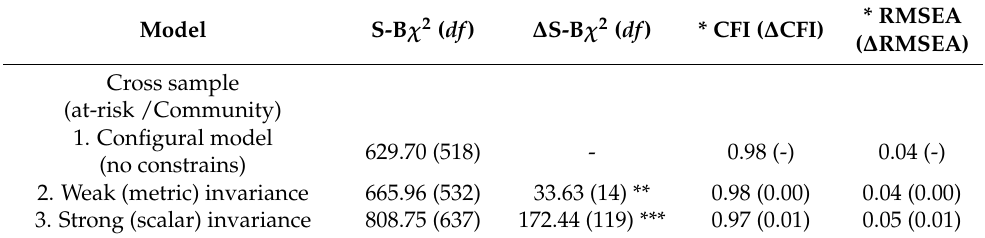
Table 3. Tests for invariance of Brief COPE goodness of fit statistics.